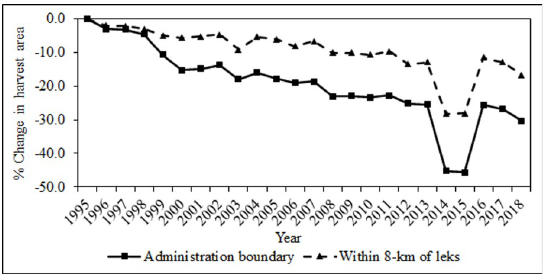
Fig 4. Change in total harvest area for greater sage-grouse across 11 western states and 2 Canadian provinces from 1995–2018, represented by total administrative boundaries (solid) and area within 8 km of known leks